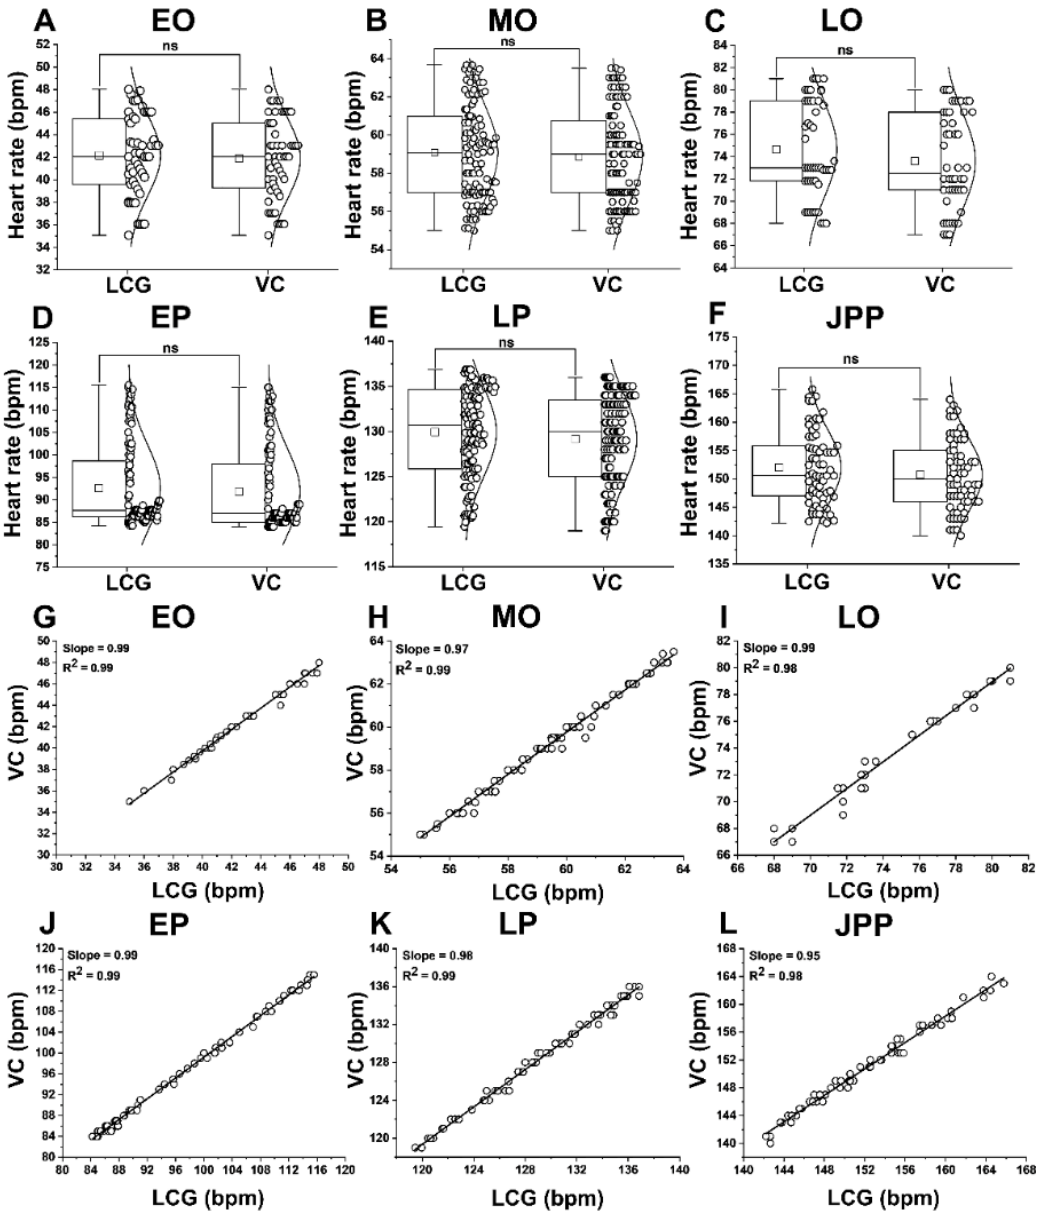
Figure 5. Box plot ( A – F ) and linear relationship ( G – L ) between visual and LCG counts of heart rate (HR) at six different developmental stages of G. holbrooki . There was a significant correlation ( p < 0.05) between the two HR counts, at the respective developmental stages. VC = visual count; LCG = light cardiogram analysis; ns = non-significant. Box plot data are presented as means ± SD. The horizontal line in each box plot separates the data distribution into upper (50%) and lower (50%) quartiles. Small square and a horizontal line on each box plot indicate mean and median values, respectively (n = 100 embryos per each developmental stage).